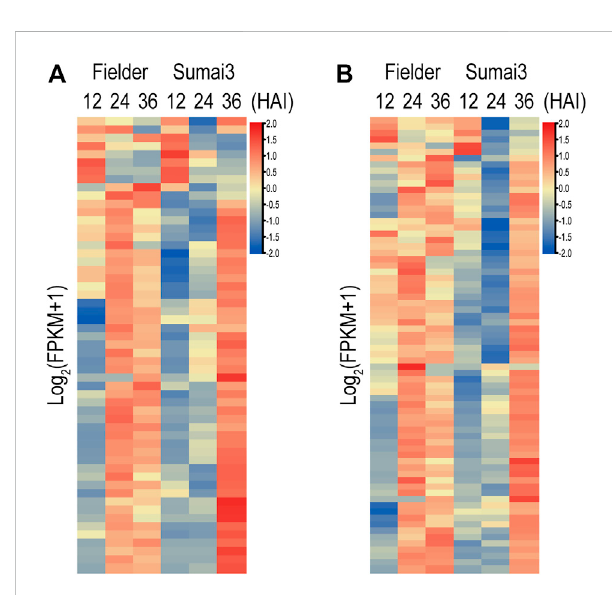
FIGURE 6 Putative fungal effectors during infection of Fielder and Sumai3 (A) Heatmap of 55 DEGs encoding putative effectors during infection of Fielder and Sumai3. (B) Evaluation of expression of 72 putative differentially expressed effectors in previous studies during infection of Fielder and